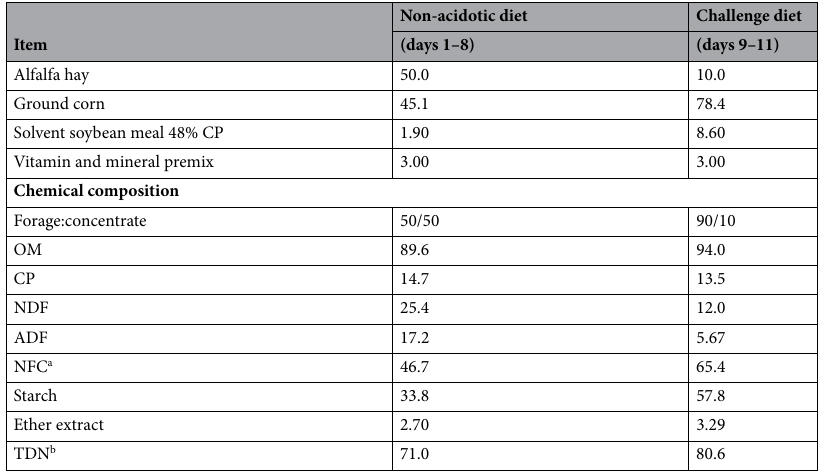
Table 4. Ingredient and chemical composition of the experimental diets (% of DM unless otherwise stated). Ingredients were milled to pass through a 1-mm screen for chemical analysis and through a 2-mm screen for experiments. a NFC (non-fiber carbohydrates) = 100 − (% NDF + % CP + % ether extract + % ash). b TDN (total digestible nutrients) = dCP + (dEther extract × 2.25) + dNDF + dNSC, which NSC (non-structural carbohydrates) = 100 – CP – EE – NDF − ash.